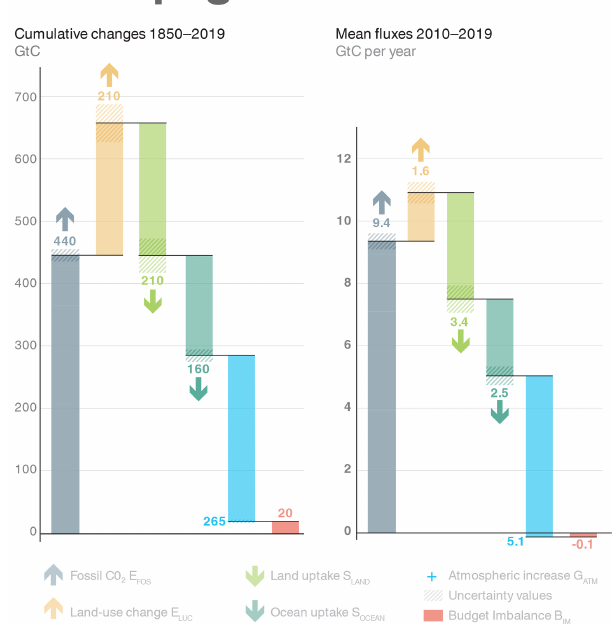
Figure 9. Cumulative changes during 1850–2019 and mean fluxes during 2010–2019 for the anthropogenic perturbation as defined in the legend. Cement carbonation sink is included in E FOS